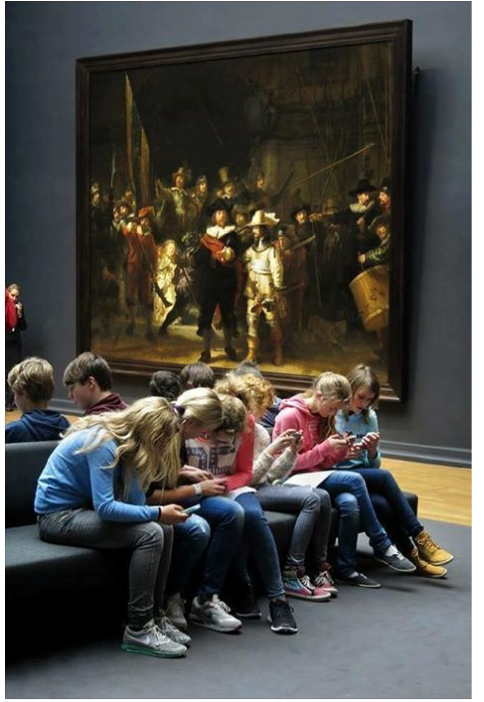
Figure 1. No Comment Necessary (Pikovsky, 2014)